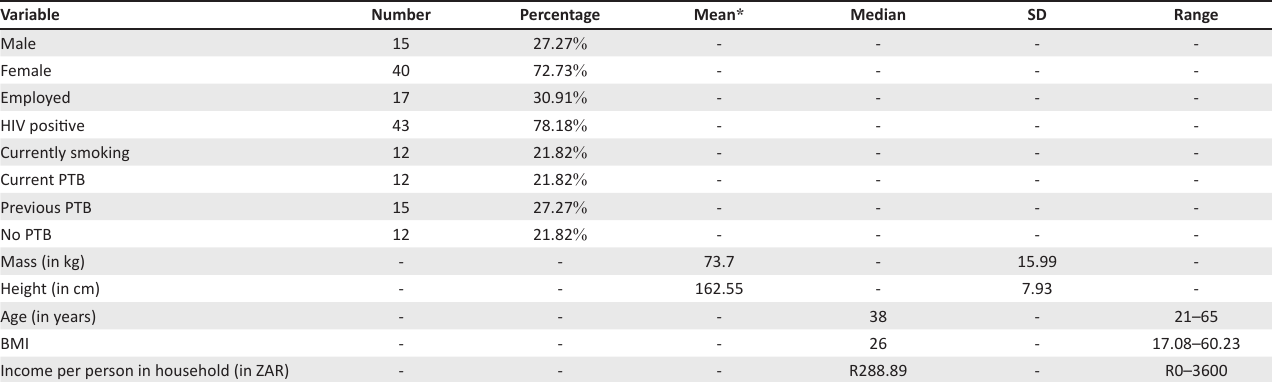
TABLE 1: Descriptive statistics of sample ( n = 55).